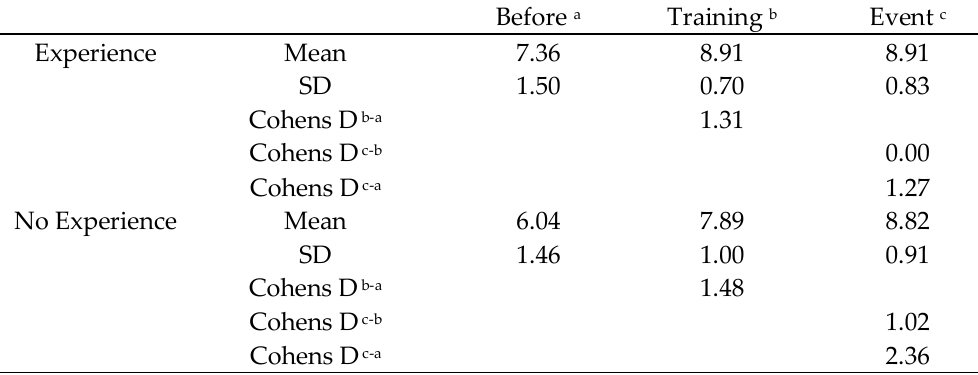
Table 4. Mean, standard deviation and Cohen's D of transplantation knowledge rating points Before